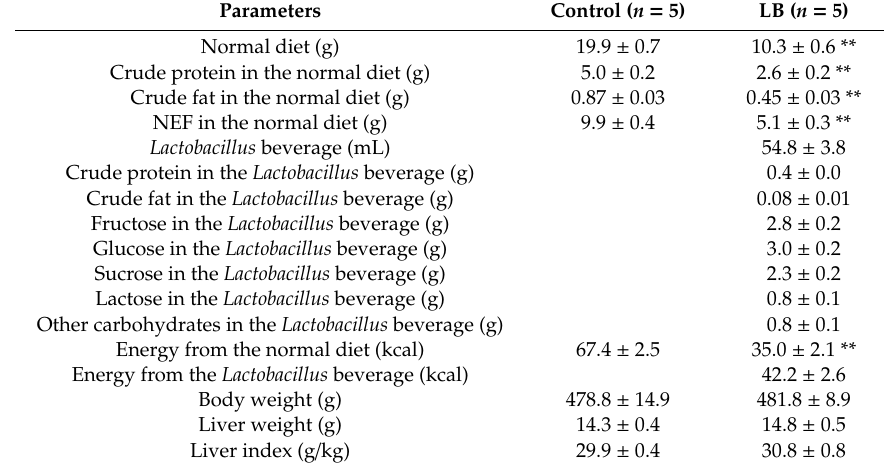
Table 4. Intake parameters of the normal diet and Lactobacillus beverage and body and liver weights.